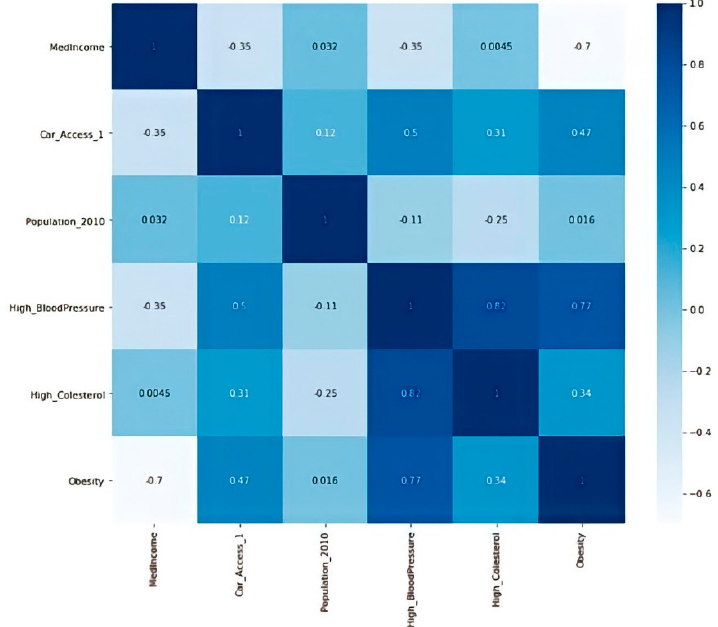
Figure 9. Correlation matrix with heatmap.